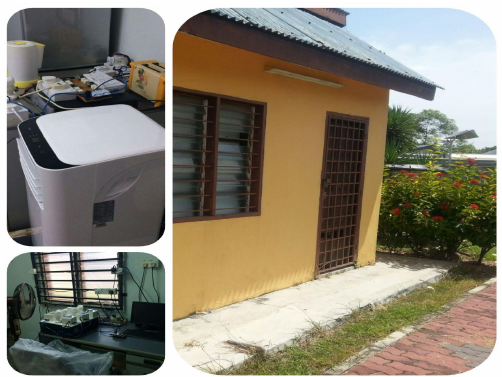
Figure 7. An on-site picture of the implemented HEMS.